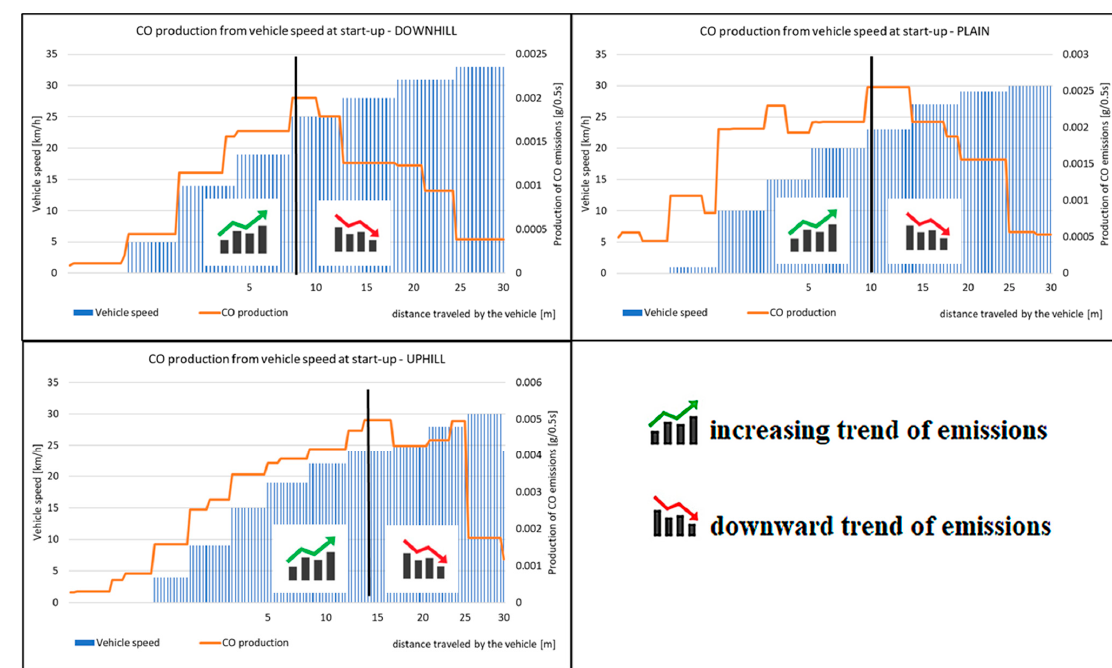
Figure 11. Comparison of the course of emissions for one start-up of the vehicle.